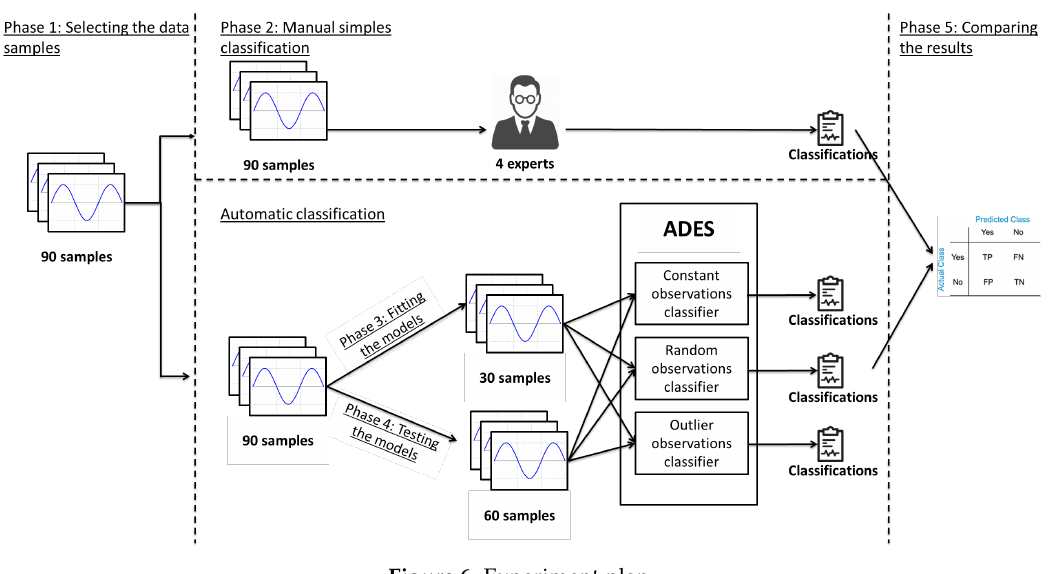
Figure 6. Experiment